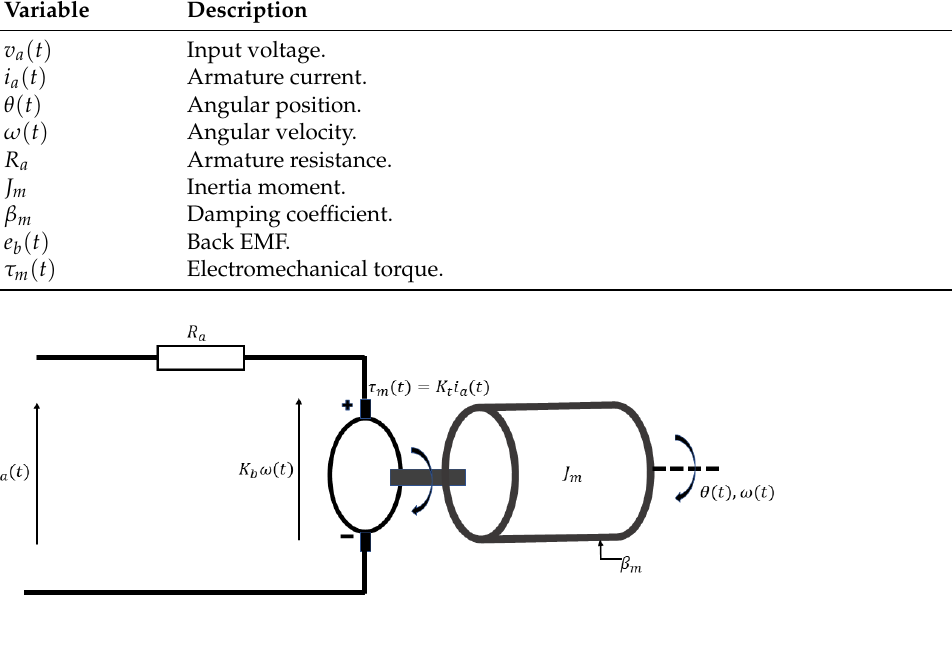
Figure 2. Linear model of the DC motor available in the